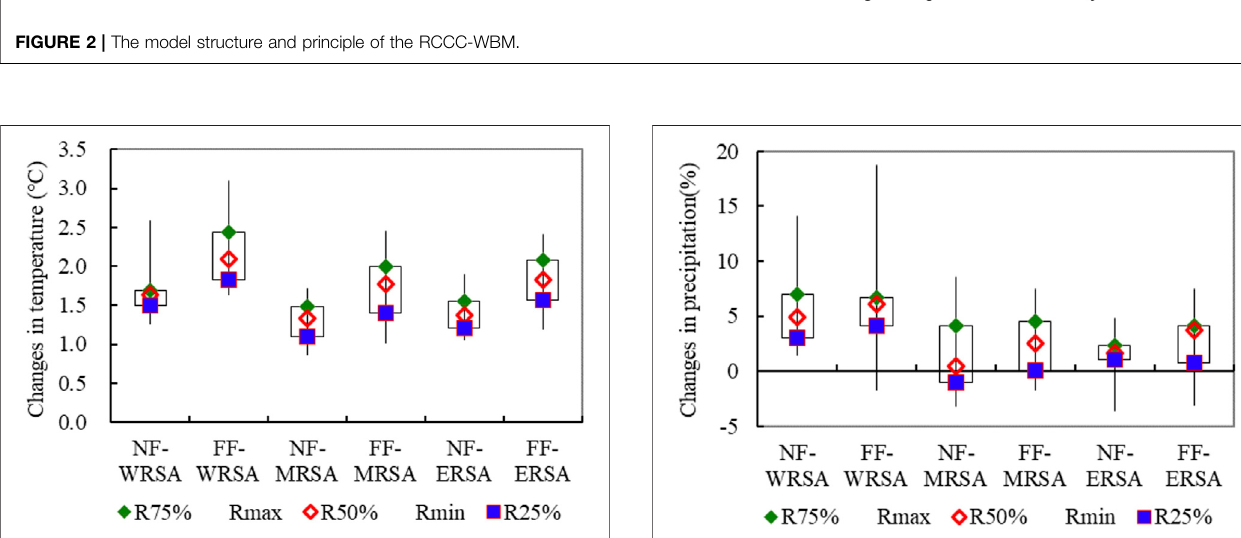
FIGURE 4 | Precipitation changes in two periods of near future (NF) and farfuture(FF)relativetobaselineof1956 – 2000forallthreesourceareasofthe South-to-North Water Diversion